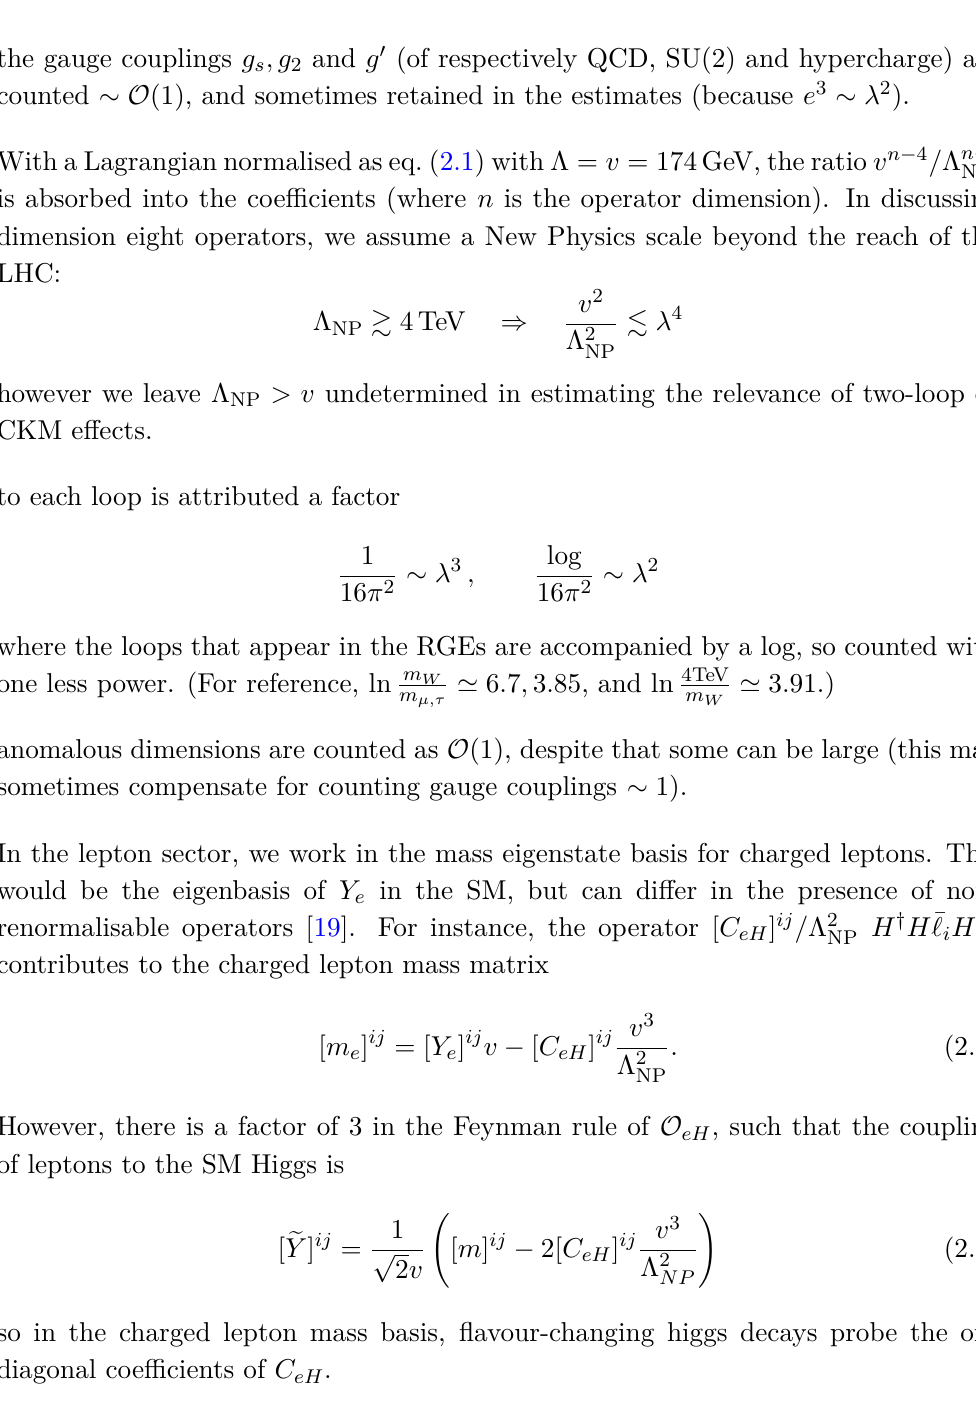
, in TeV, such that ( v/ Λ ) 2 = λ k (where v = 174 NP NP